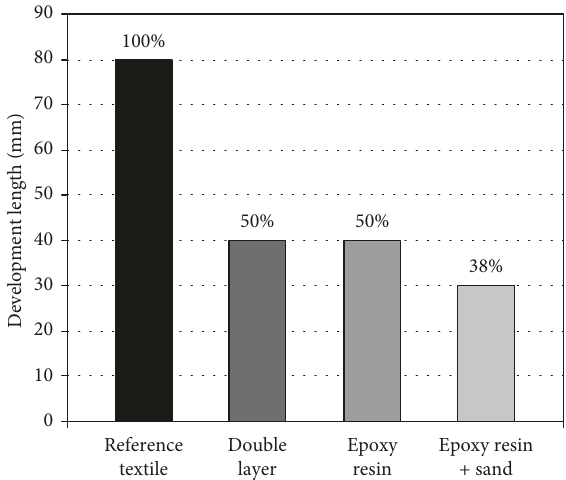
Figure 16: Comparison of the development